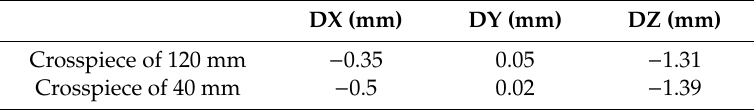
Table 11. Displacement in the support between connecting rod and arches.